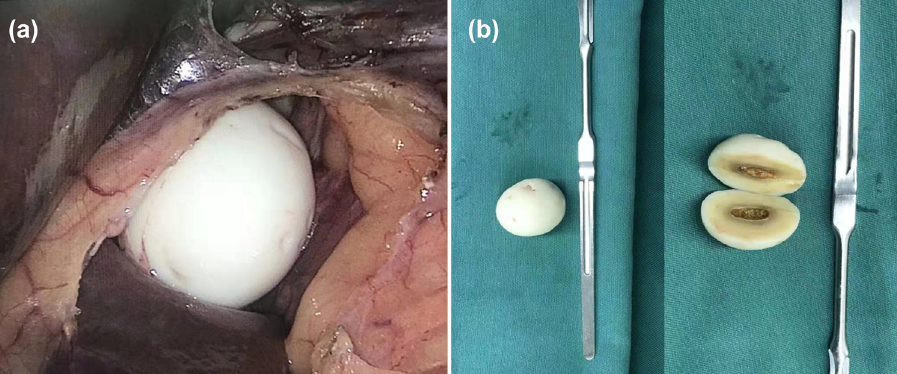
Figure 2: Laparoscopy ( a ) presents a pure white, elastic, egg - shaped body in the second hilar region and near the caudate lobe. Gross pathologic examination ( b ) presents a lesion of white in appearance with a smooth surface. The cross - section displays a core fi lled with yellow